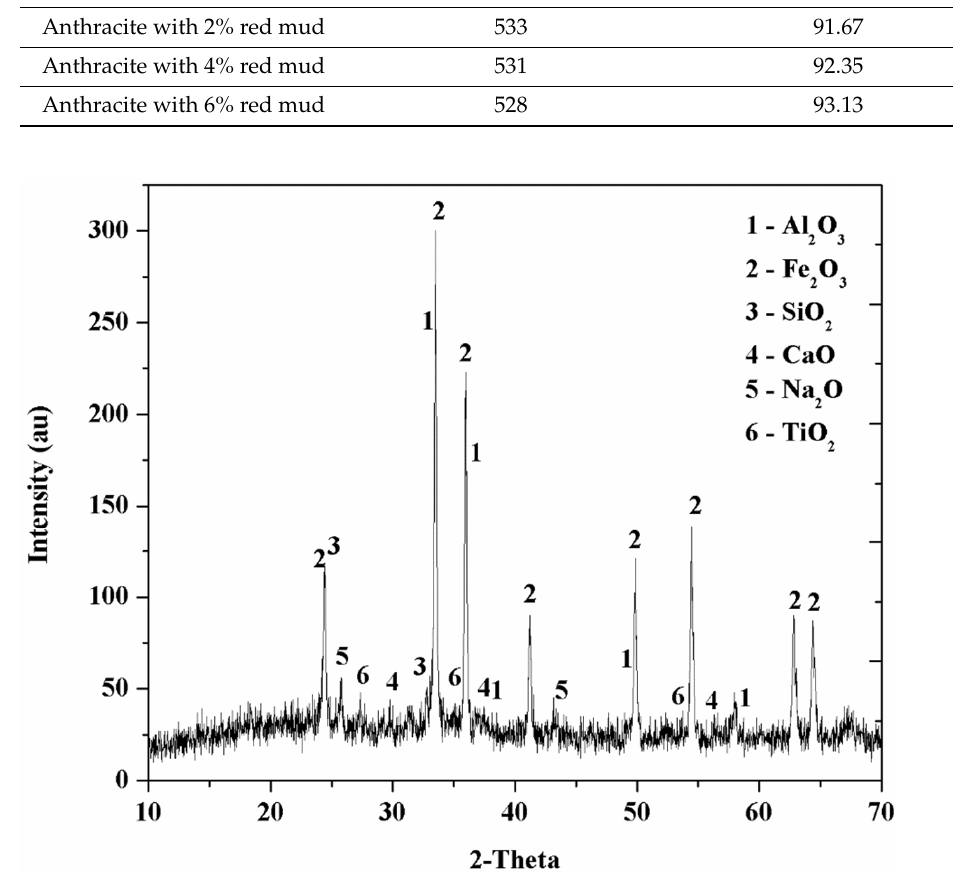
Figure 3. XRD pattern of red mud after decomposition.